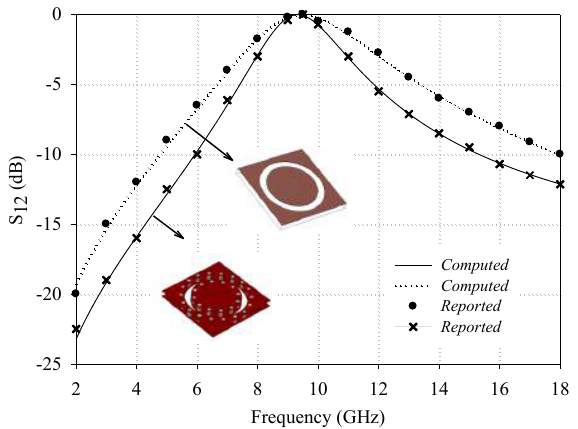
Figure 10. Transmission coefficient of FSS and SIW cavity FSSs. Solid and dotted lines show computed results at dept. of ECE, NITT. Bubbles and cross show reported results from Figure 4.a in